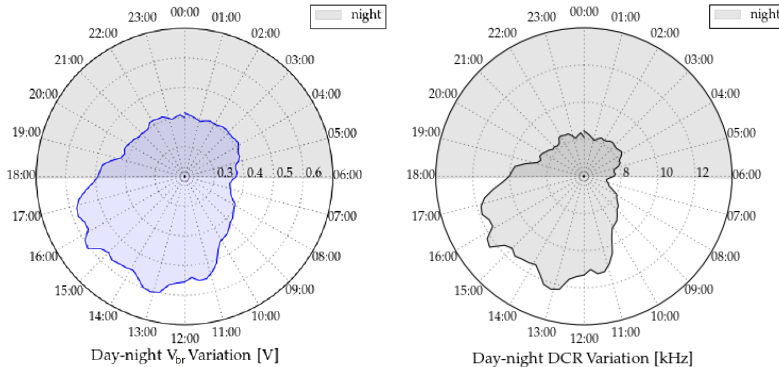
Figure 13. MuTe SiPM breakdown voltage ( left ) and DCR ( right ) variation as a function of the temperature values at the Cerro Machín volcano.